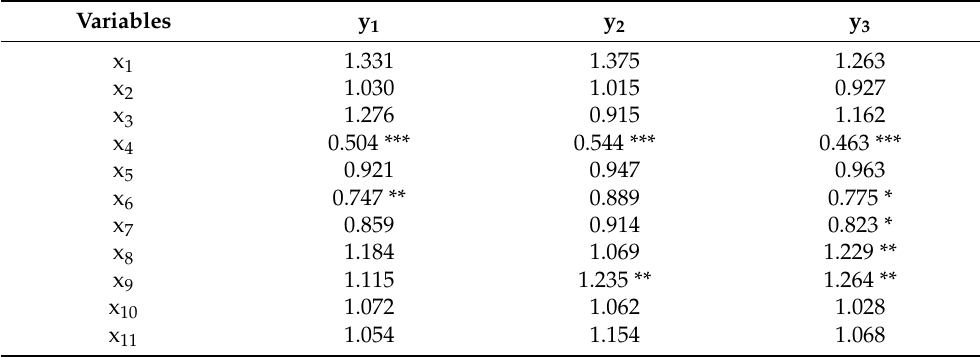
Table 10. Odds ratios for model 4 (y 1 , y 2 and y 3 ).